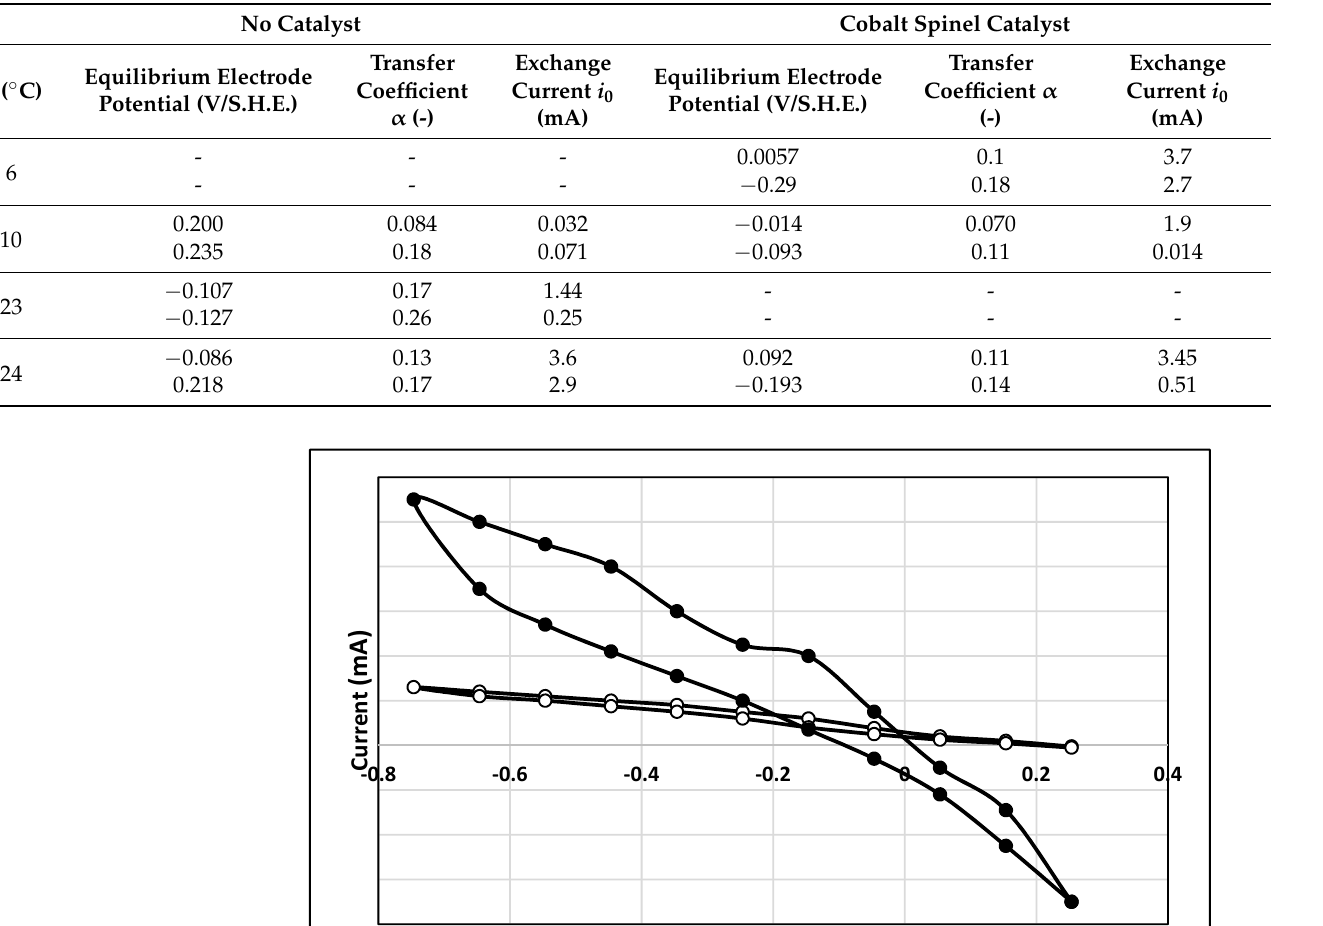
Table 3. Kinetic data obtained for the anode compartment, with carbon felt as electrode with and without embedded cobalt spinel at different temperatures. Sulfide concentration 63 mg dm − 3 .